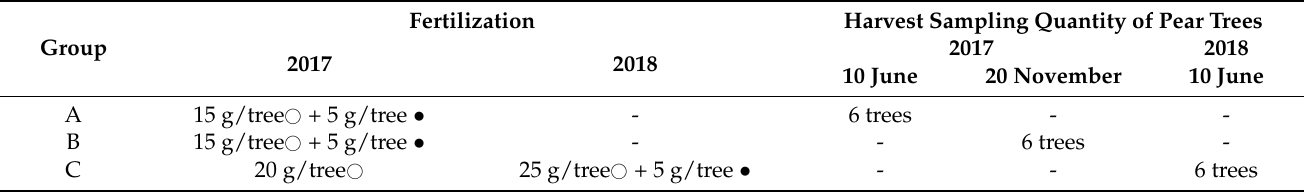
Table 1. The timing and rate of fertilization, the harvest sampling time, and quantity of pear trees in each